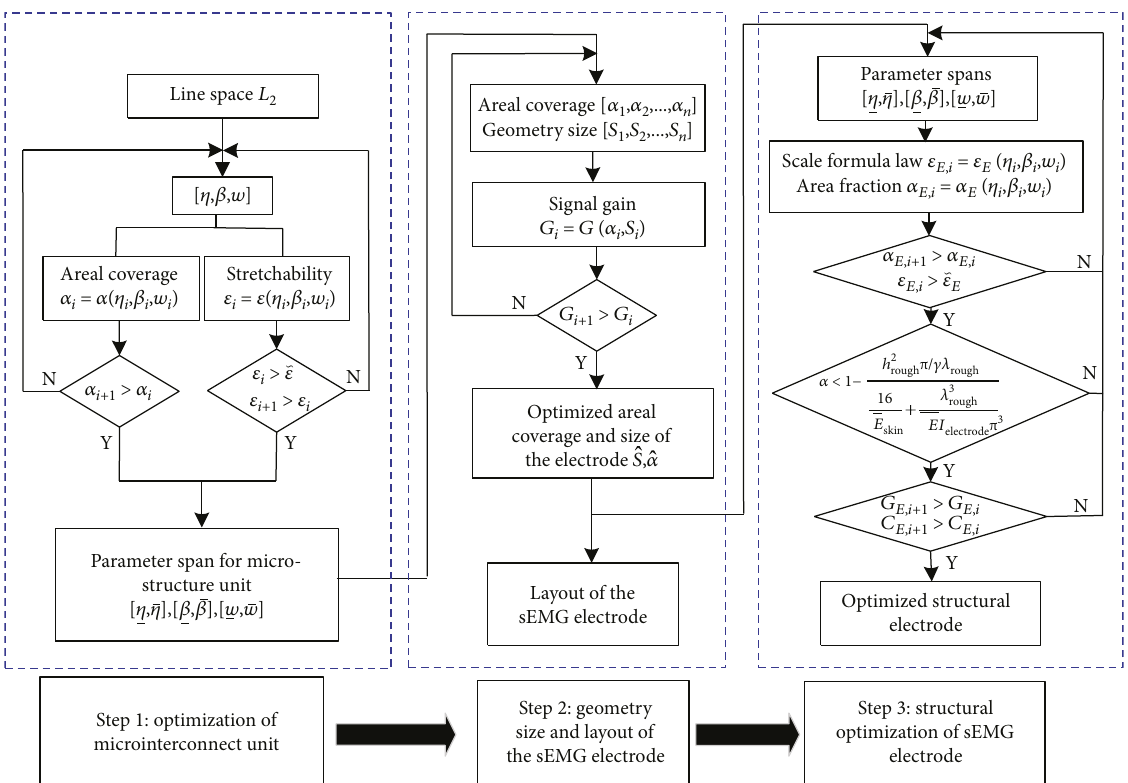
Figure 2: Solving process chart for the optimized structural design of surface